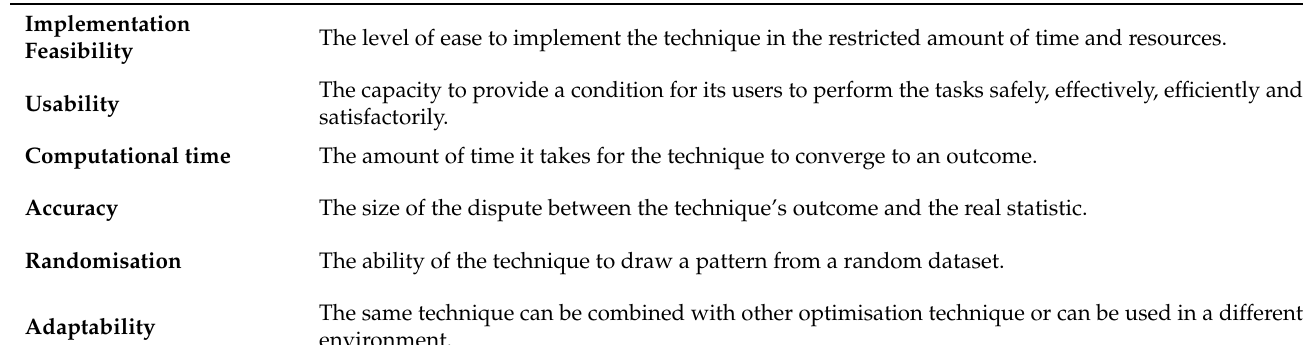
Figure 1. Procedures for establishing multi-criteria analysis (MCA). Table 1. The set of chosen criteria for the